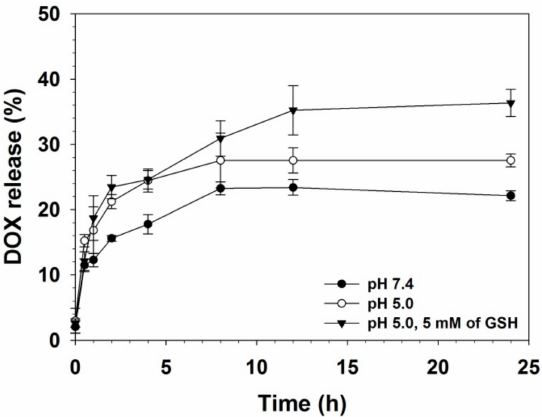
Figure 7. DOX release profile of PK 5 E 7 (PEI-rGO / DOX) in various condition (pH 7.4, pH 5.0, and pH 5.0 with 5 mM of GSH). Data are shown as the mean ± S.D ( n =